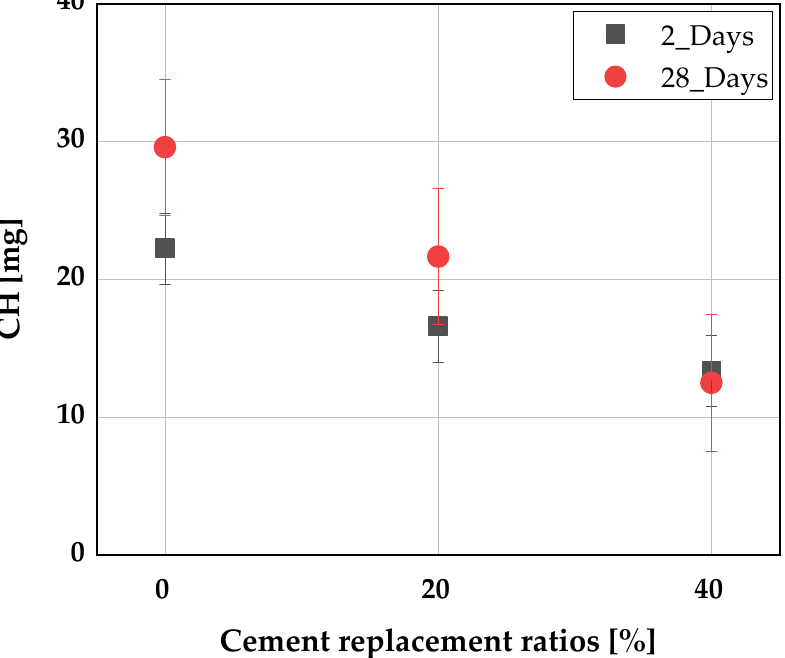
Figure 12. Portlandite (CH) in [mg] at 2 and 28 days of hydration.